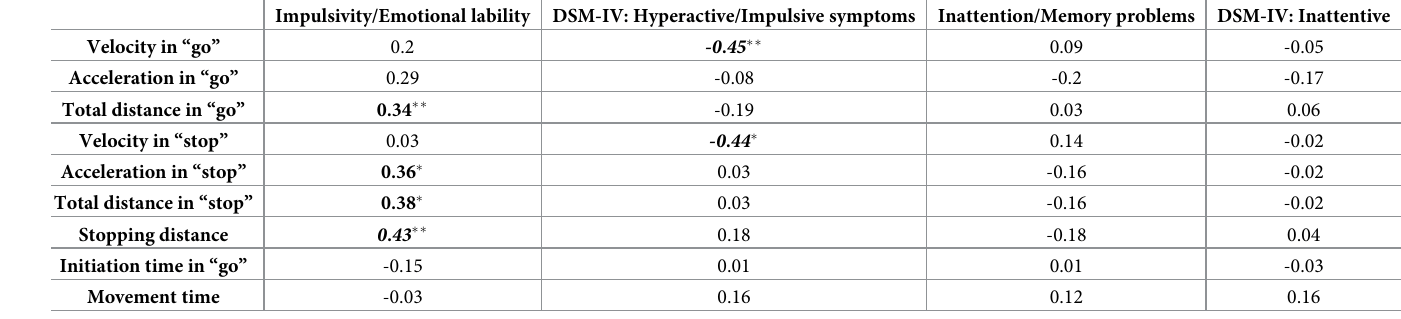
Table 5. Values of Spearman’s ρ for correlations between mouse movement and impulsivity/inattention